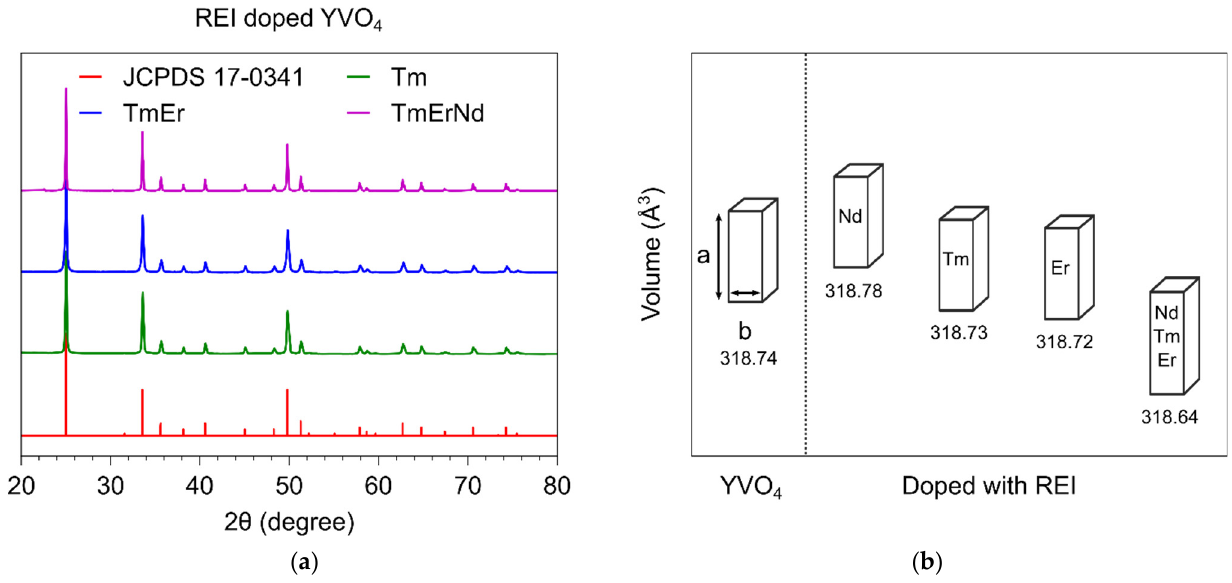
Figure 1. ( a ) XRD patterns and ( b ) unit cell volume of the YVO 4 samples doped with different rare earth ions.